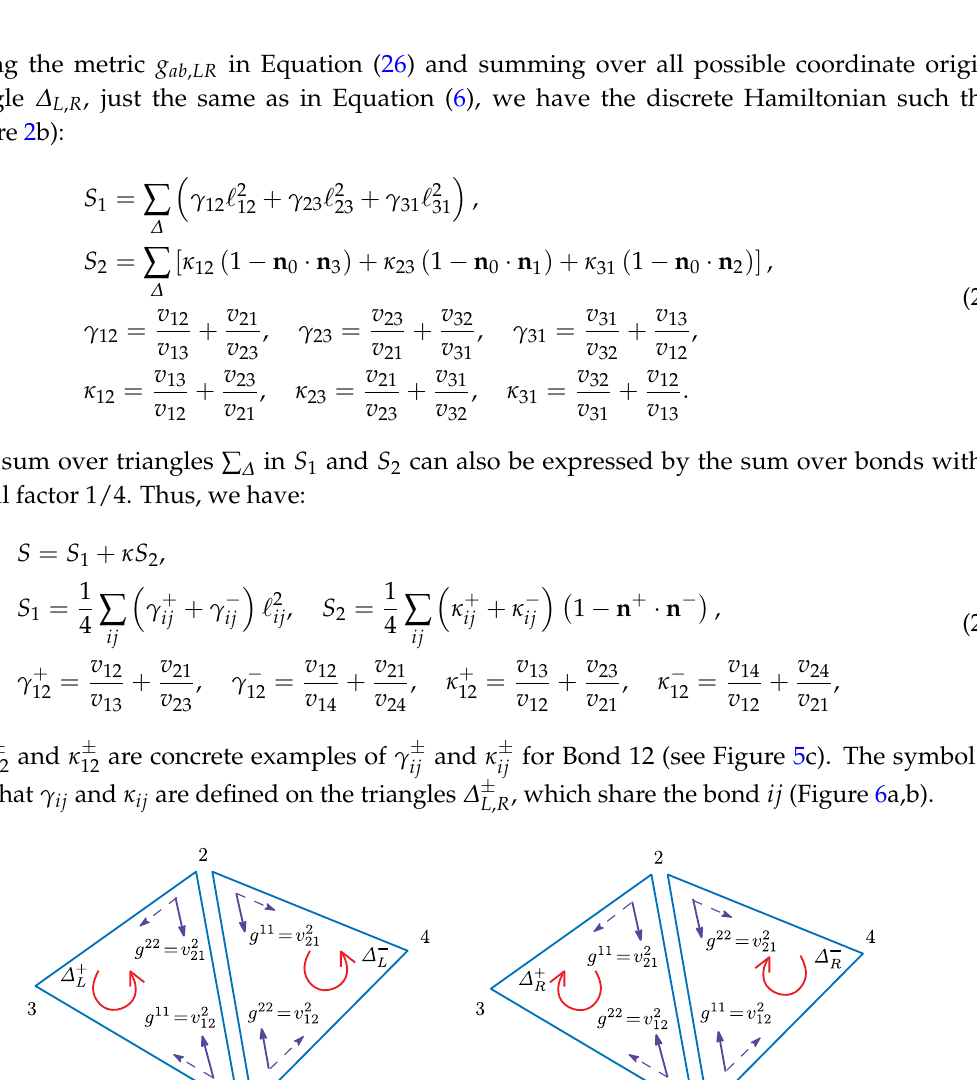
and ∆ − , which share Bond 12: ( a ) ∆ + L , R L , R and ∆ − (inside view) of those in (a). Elements of the inverse R R and v 2 , which are defined on Bond 12 21